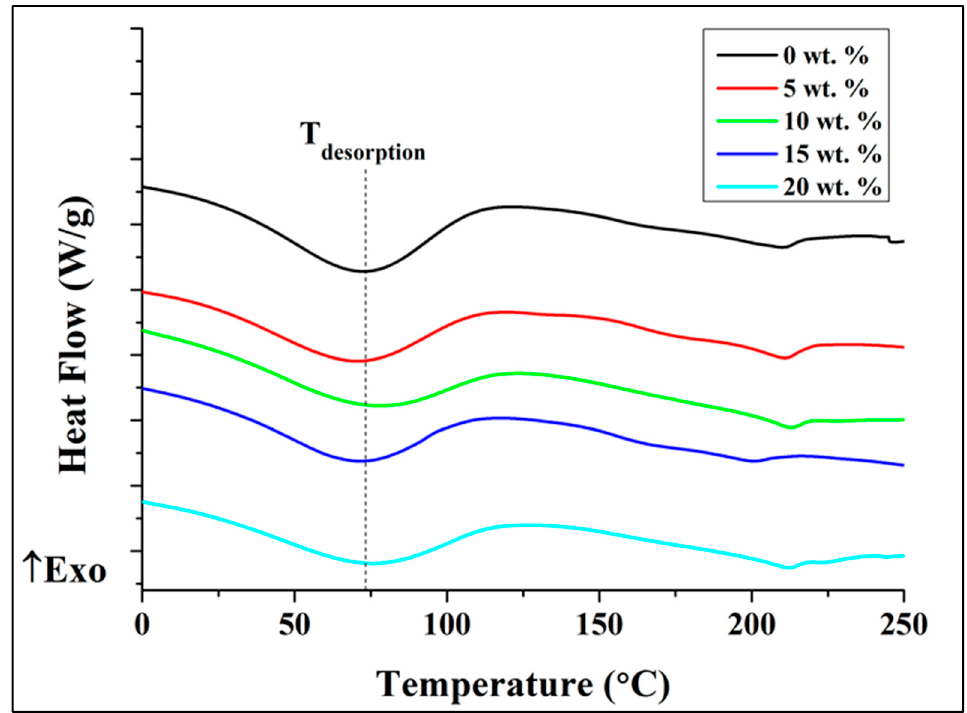
Figure 7. DSC first heating curves for the CA/AlN composites.